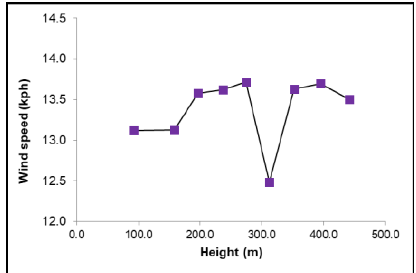
Figure 22. Vertical profile of wind speed during the flight